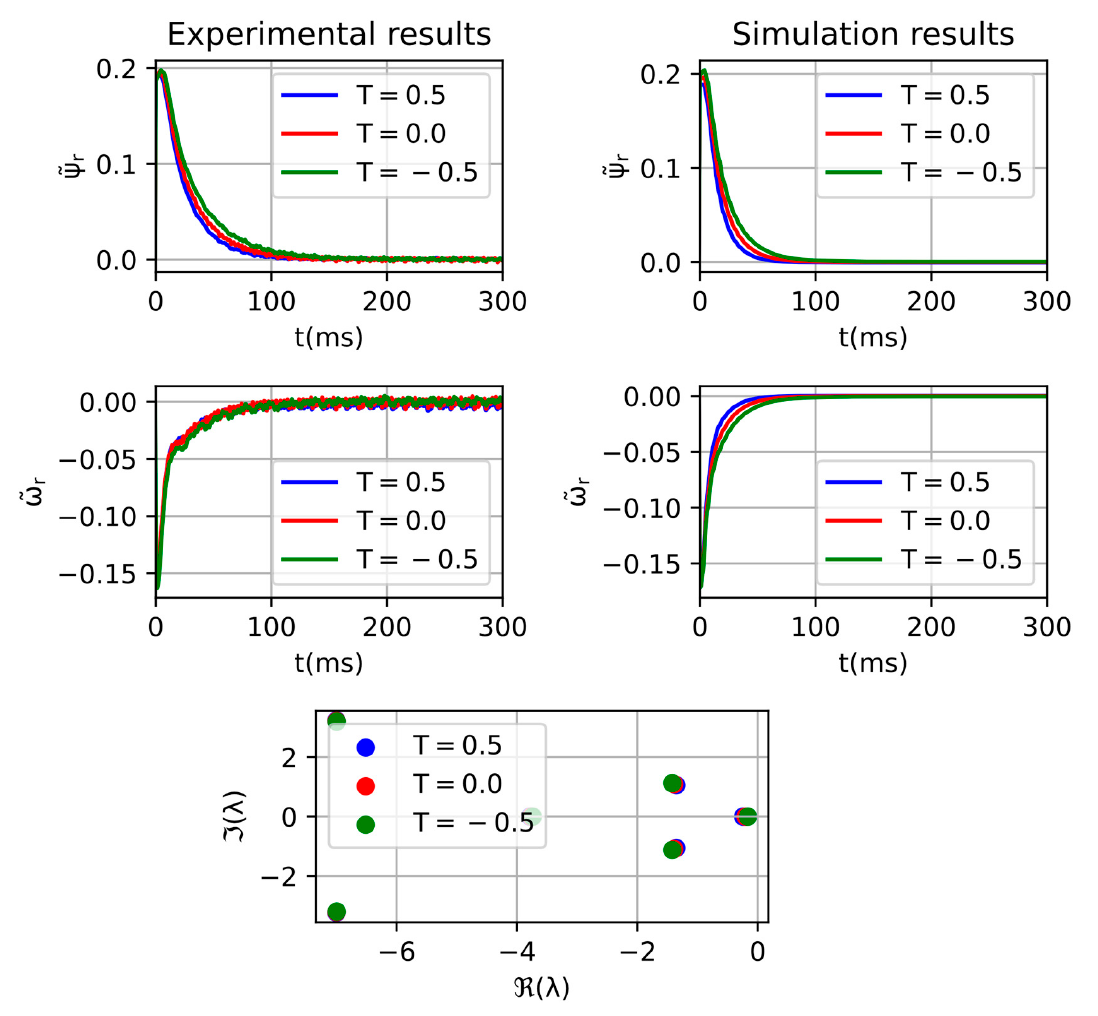
Figure 12. Experimental and simulation studies of the influence of the load torque on the poles placement and impulse response of the observer at nominal rotor speed and rotor flux.